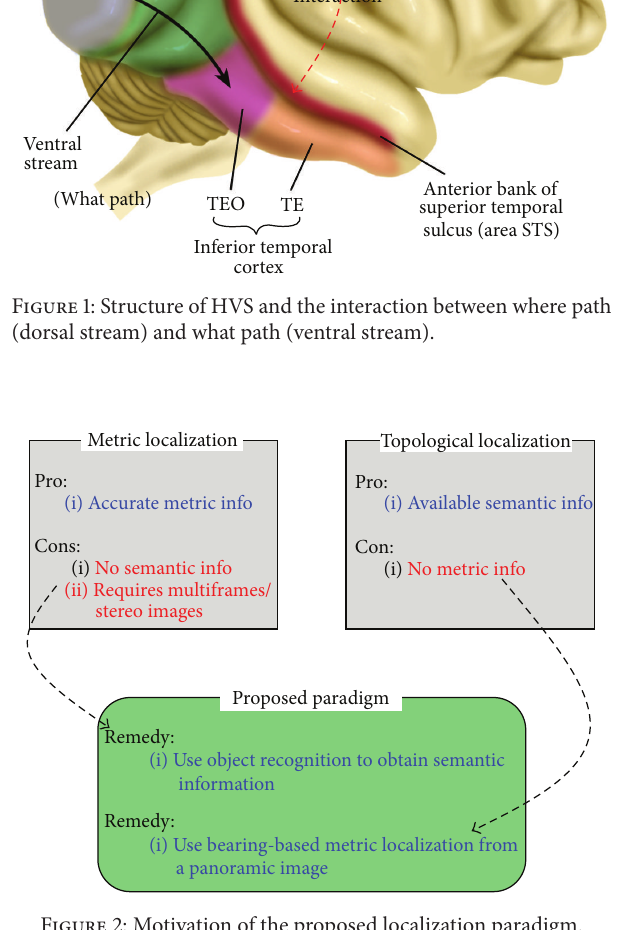
Figure 2: Motivation of the proposed localization